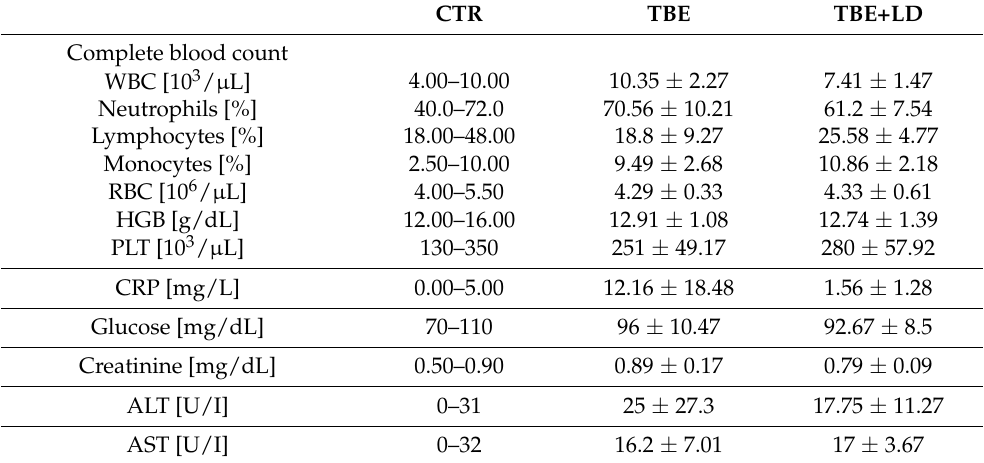
Table 2. Comparison of laboratory data of TBE and TBE co-infected (TBE+LD) patients with healthy subjects